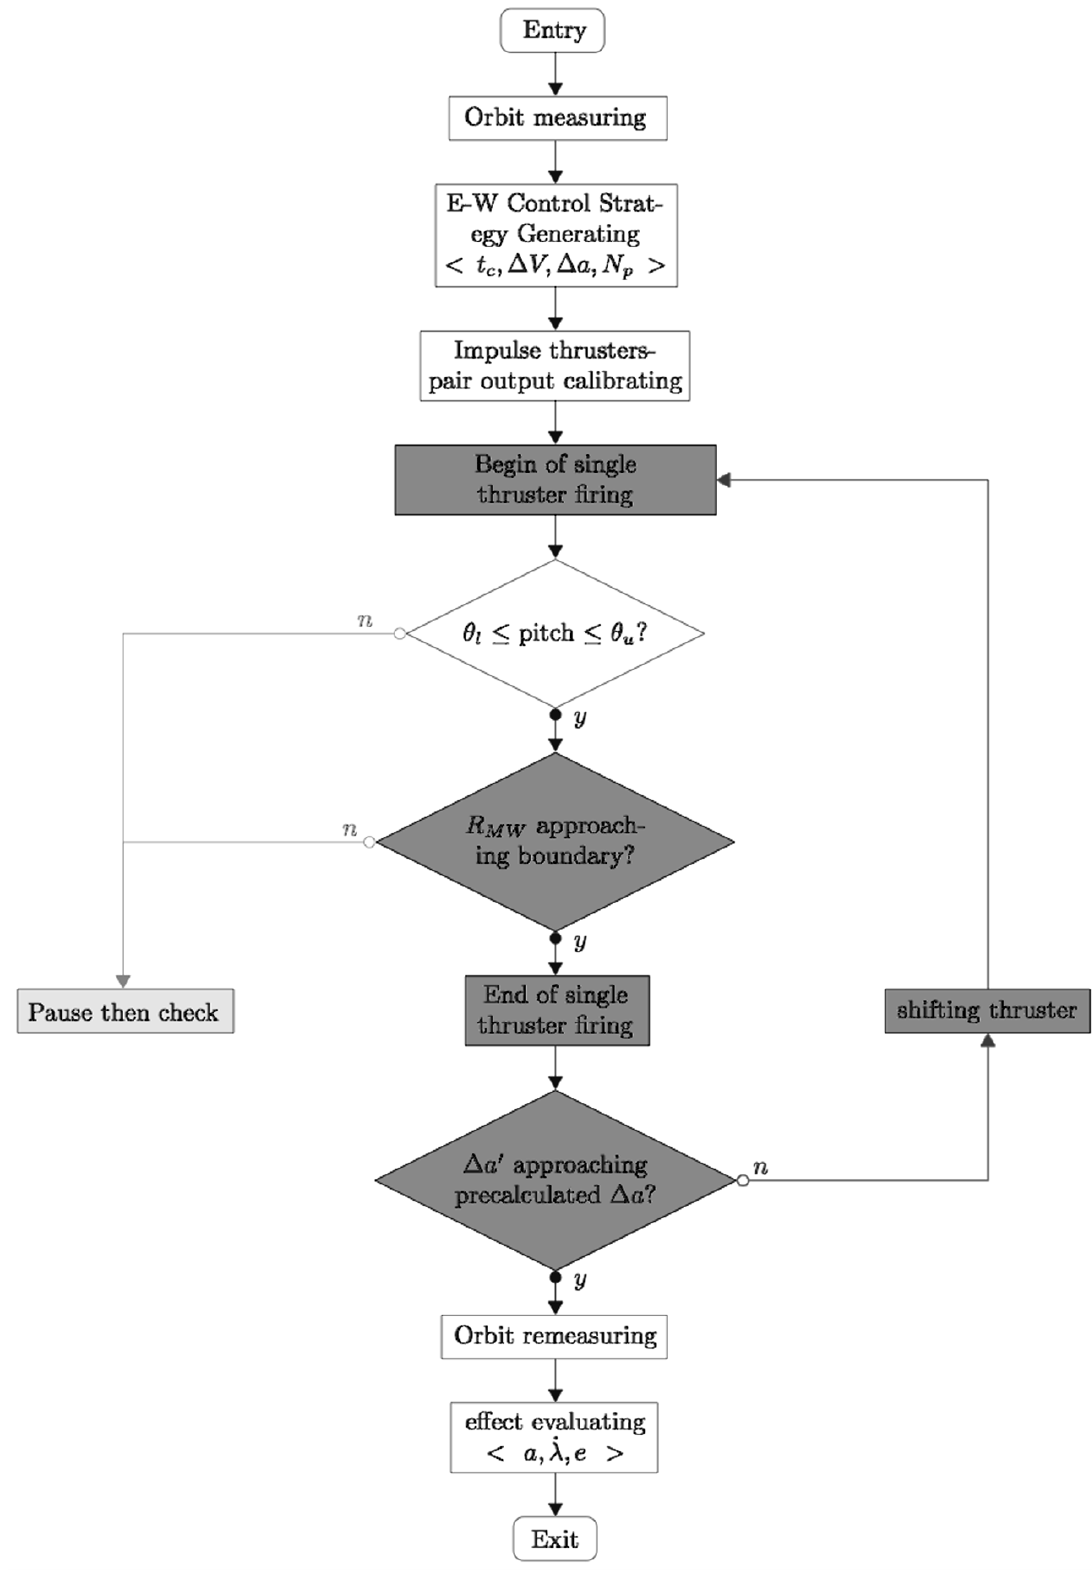
Figure 15. Modified workflow for degraded thruster